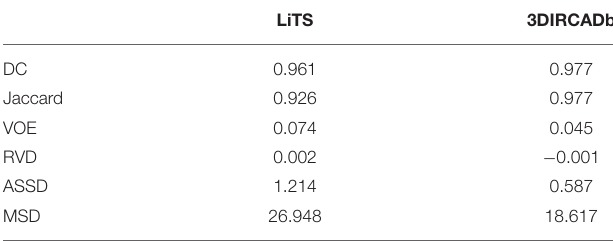
TABLE 3 | Evaluation results of the liver segmentation on the LiTS test dataset and the 3DIRCADb dataset.